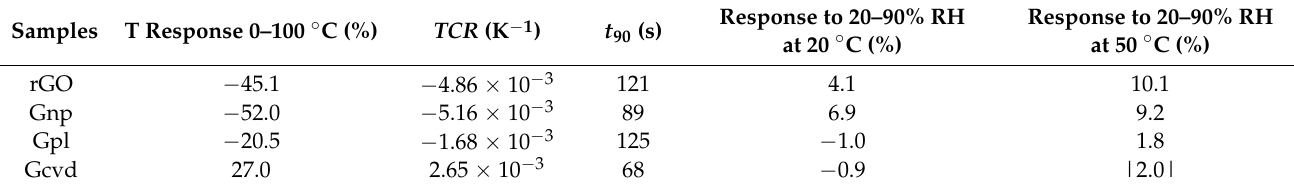
Table 2. Temperature and humidity parameters of graphene-based